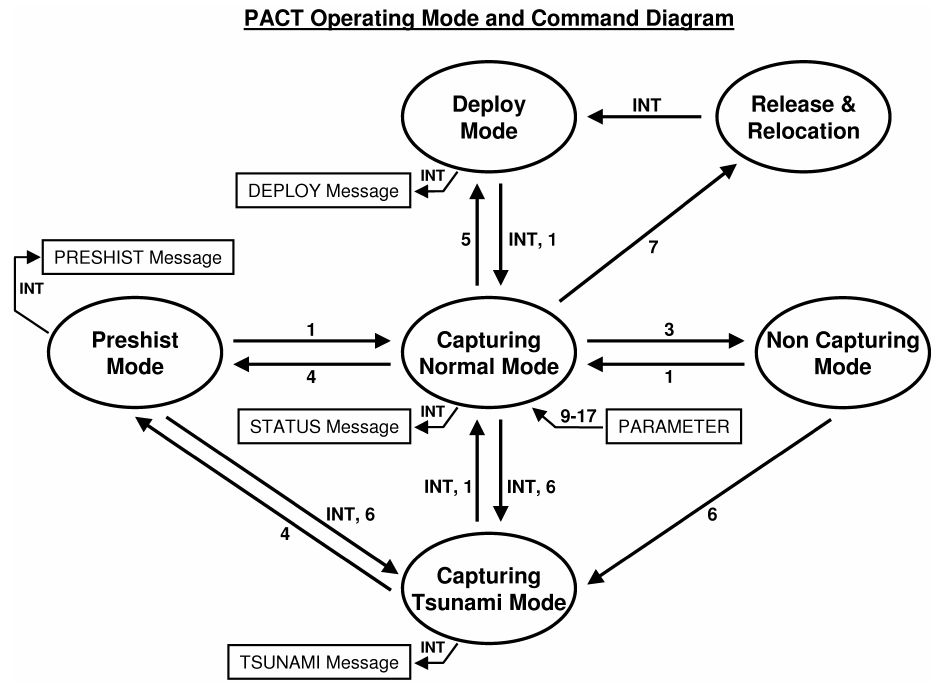
Fig. 8. PACT operating modes and command structure. Ellipses symbolize the six operating modes. Arrows indicate possible transitions between these modes, which may be initiated either by external commands # 1, 3, 4, 5, 6 and 7, or internally via firmware control (INT). Rectangles indicate the four messages types that are generated by the firmware and a set of parameters with may be uploaded to the PACT-BU via commands